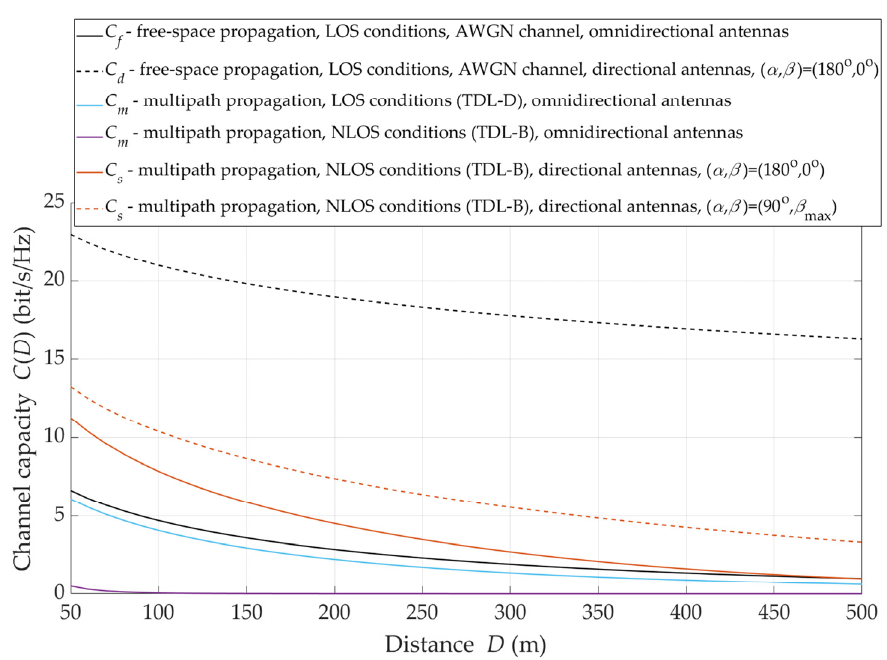
Figure 14. Channel capacity versus TX–RX distance for straight and optimal directions of antenna beams under NLOS conditions.